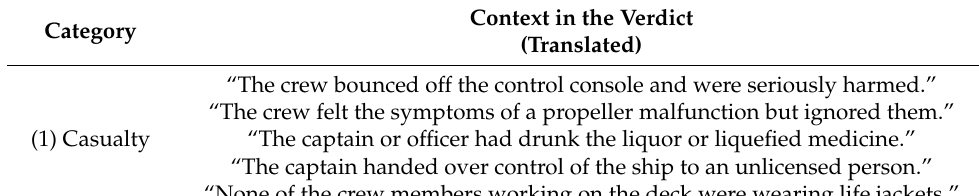
Table 9. Context of the extracted words from the original